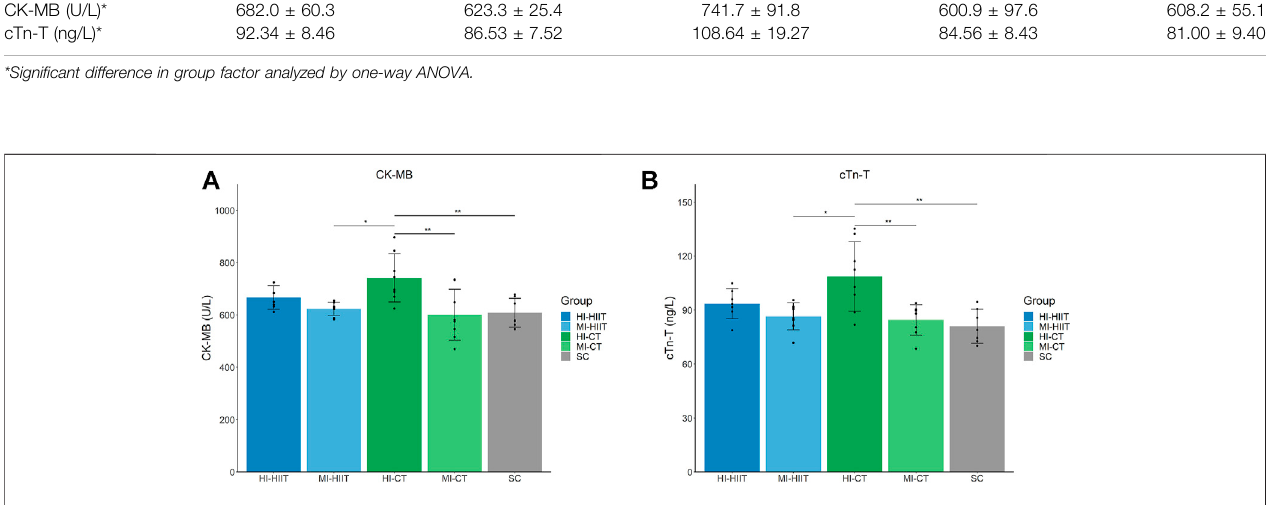
FIGURE 2 | (A) Distribution of CK-MB in each group. HI-CT group demonstrated higher CK-MB than MI-HIIT ( p = 0.015), MI-CT ( p = 0.003) and SC ( p = 0.007) groups. (B) DistributionofcTn-Tineachgroup.HI-CTgroupdemonstratedhighercTn-TthanMI-HIIT( p =0.005),MI-CT( p =0.002)andSC( p =0.001)groups.HI-HIIT: high training intensity HIIT group; MI-HIIT: moderate training intensity HIIT group; HI-CT: high training intensity CT group; MI-CT: moderate training intensity CT group; SC: sedentary control group; cTn-T: Cardiac troponin T; CK-MB: creatine kinase myocardial